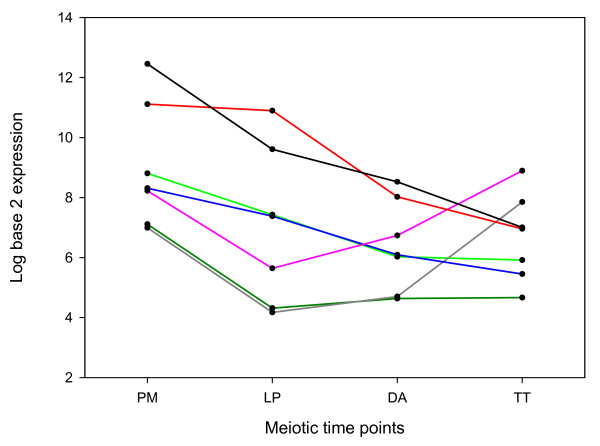
Transcripts with at least an eight-fold change in expression level between and including pre-meiosis to telophase II. Black = TaAffx.9800.1.S1_at; red = TaAffx.60258.2.S1_s_at; light green = Ta.10020.1.S1_at; blue = Ta.6922.1.S1_at; pink = TaAffx.38162.1.S1_at; dark green = Ta.16669.1.S1_x_at; and grey = Ta.6831.1.S1_at. PM, LP, DA and TT are as described in Figure 1.